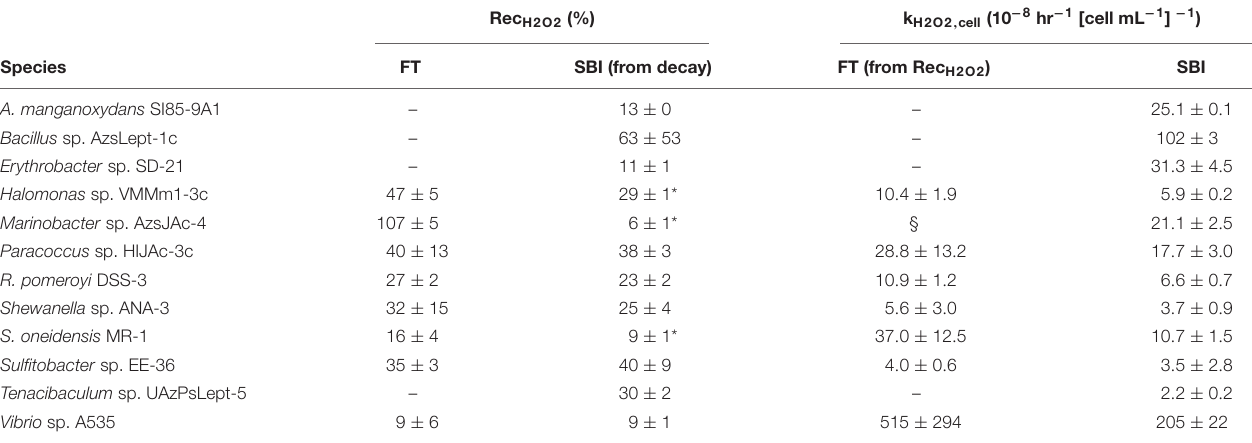
TABLE 2 | Calculated values for hydrogen peroxide recoveries (Rec H2O2 ) and normalized decay rate coefficient k H2O2 , cell for both spiked batch incubation (SBI) and flow-through (FT) methods for SBI. Rec H2O2 (%)